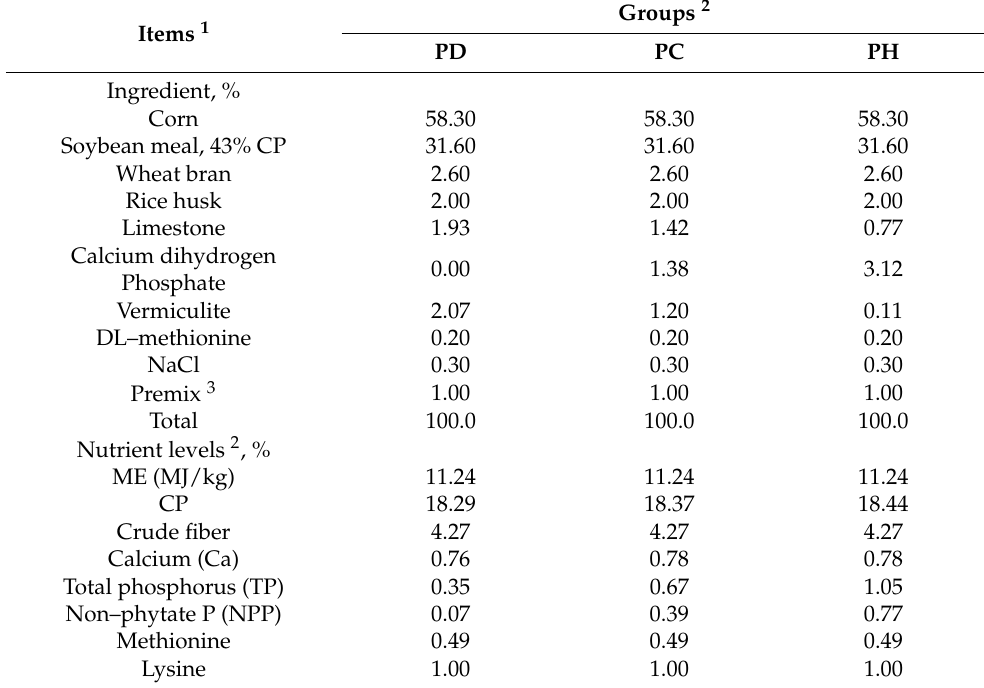
Table 1. Composition and nutrient levels of experimental diets (air-dry